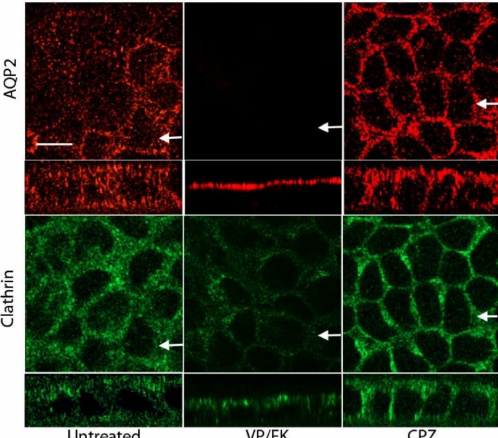
Figure 1. Chlorpromazine (CPZ) causes basolateral redistribution of aquaporin-2 (AQP2) in polarized Madin–Darby canine kidney (MDCK) cells: AQP2-MDCK cells were untreated (left panels) or